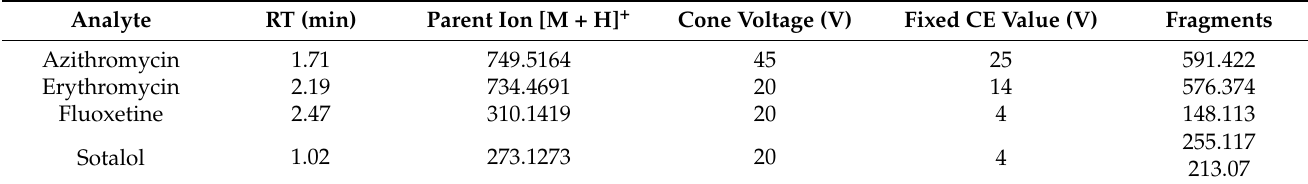
Table 2. Pharmaceuticals retention time and MS/MS operating conditions.